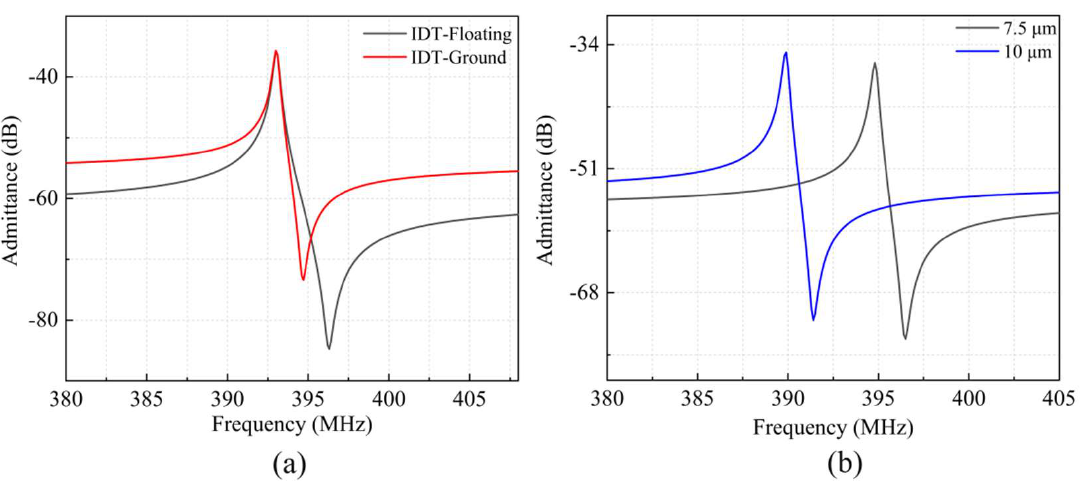
Figure 4. The simulated admittance curves of ( a ) IDT-Floating and IDT-Ground electrode structure, ( b ) 7.5 μm and 10 μm electrode width. ( b ) 7.5 µ m and 10 µ m electrode